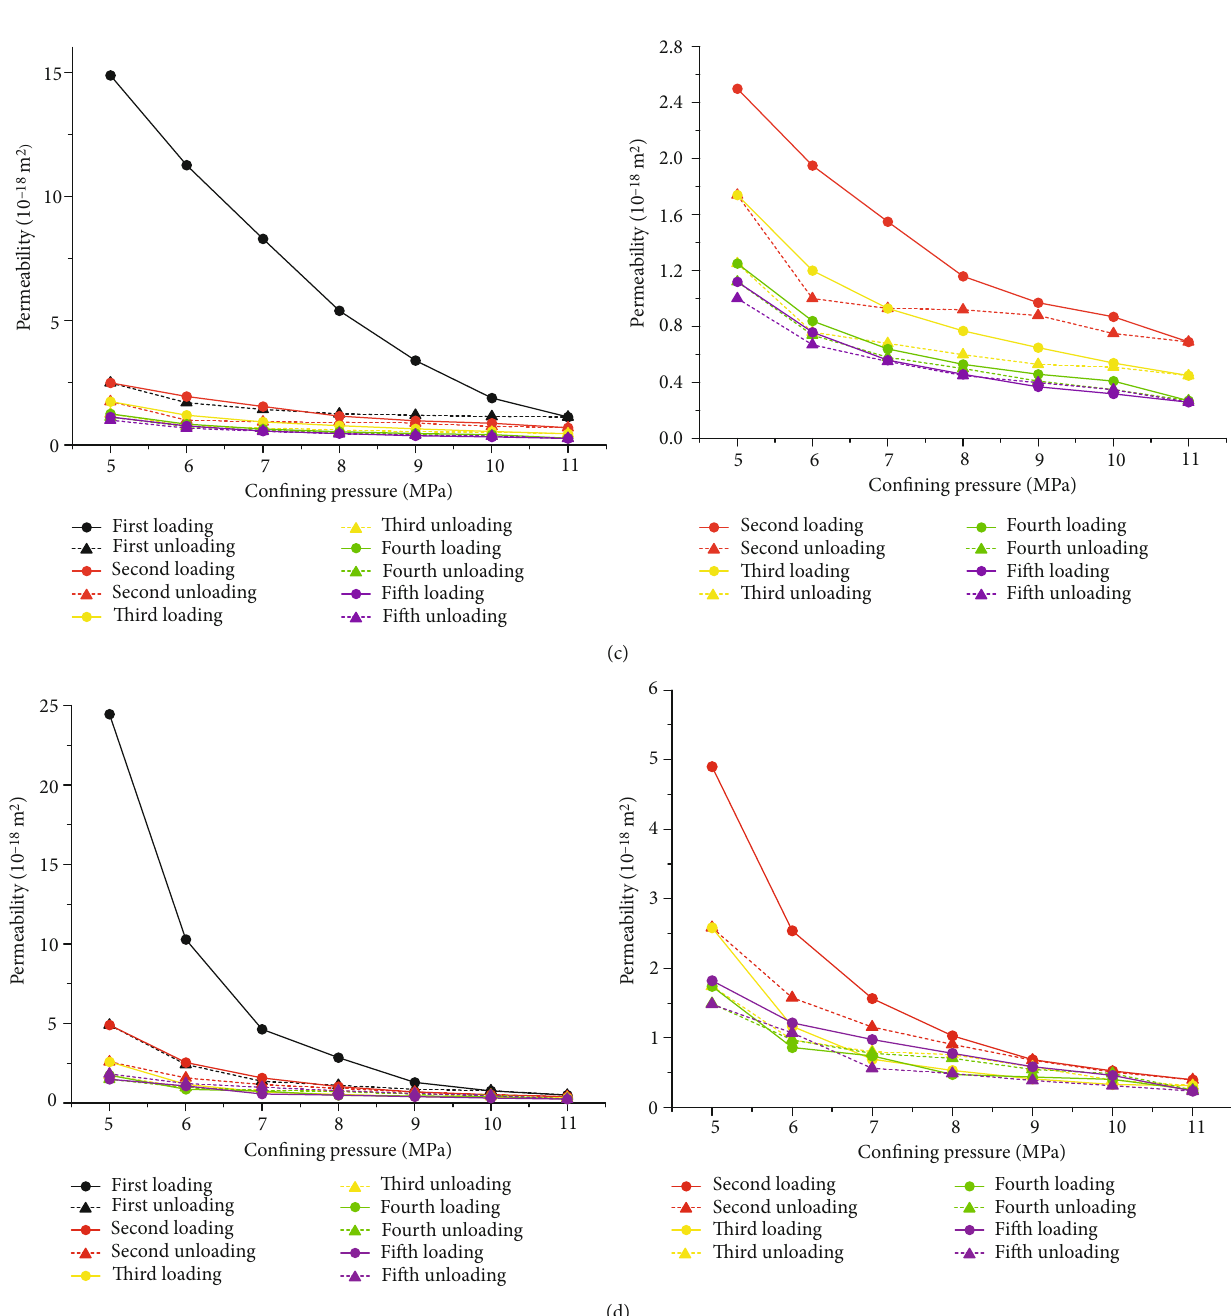
Figure 6: The permeability variation of the hydrated shale considering cycling loading and unloading conditions. The labels in Fig.6 are as follws, (a) No hydration (b) 2days (c) 5 days (d) 10